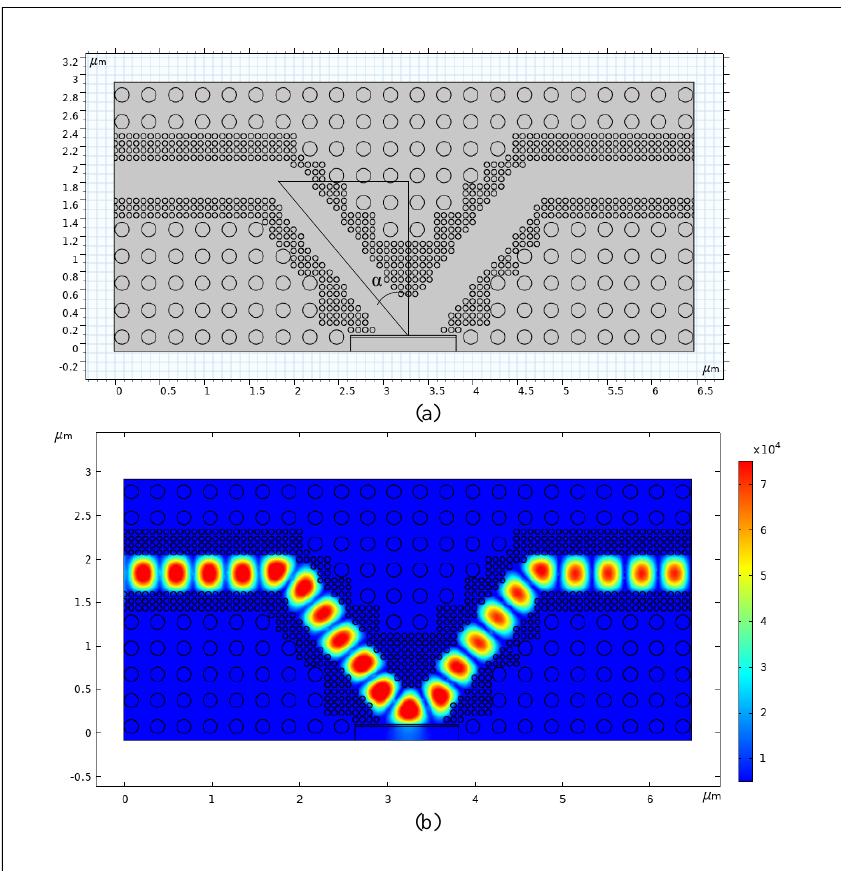
Figure 11. ( a ) The PhC structure consists of large GaAs nanorods and small Au nanorods to create a deflection angle of 41°. ( b ) The TE mode electric field propagated in the PhC waveguide section corresponding to part a.